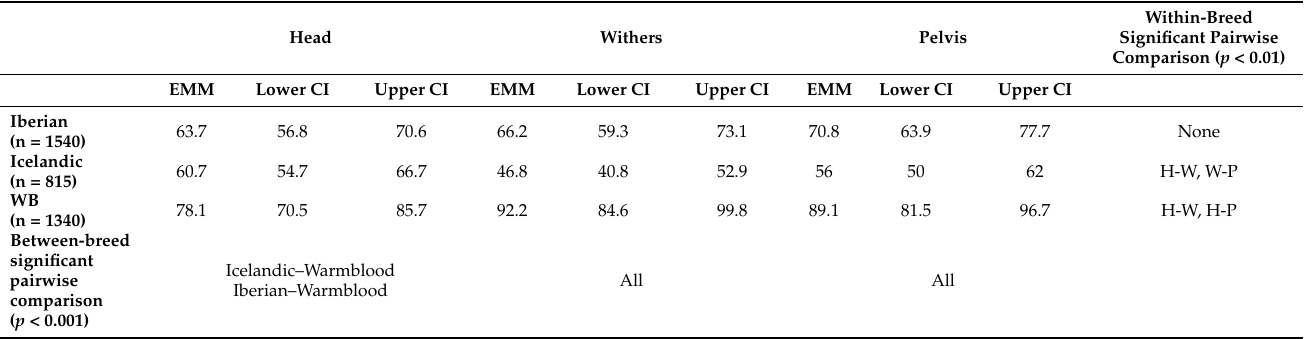
Table 3. Vertical range of motion (mm) at trot in hand for head (H), withers (W) and pelvis (P). Values presented are estimated marginal means (EMM) with confidence intervals (CI) from the linear mixed model with pairwise comparisons. n = number of